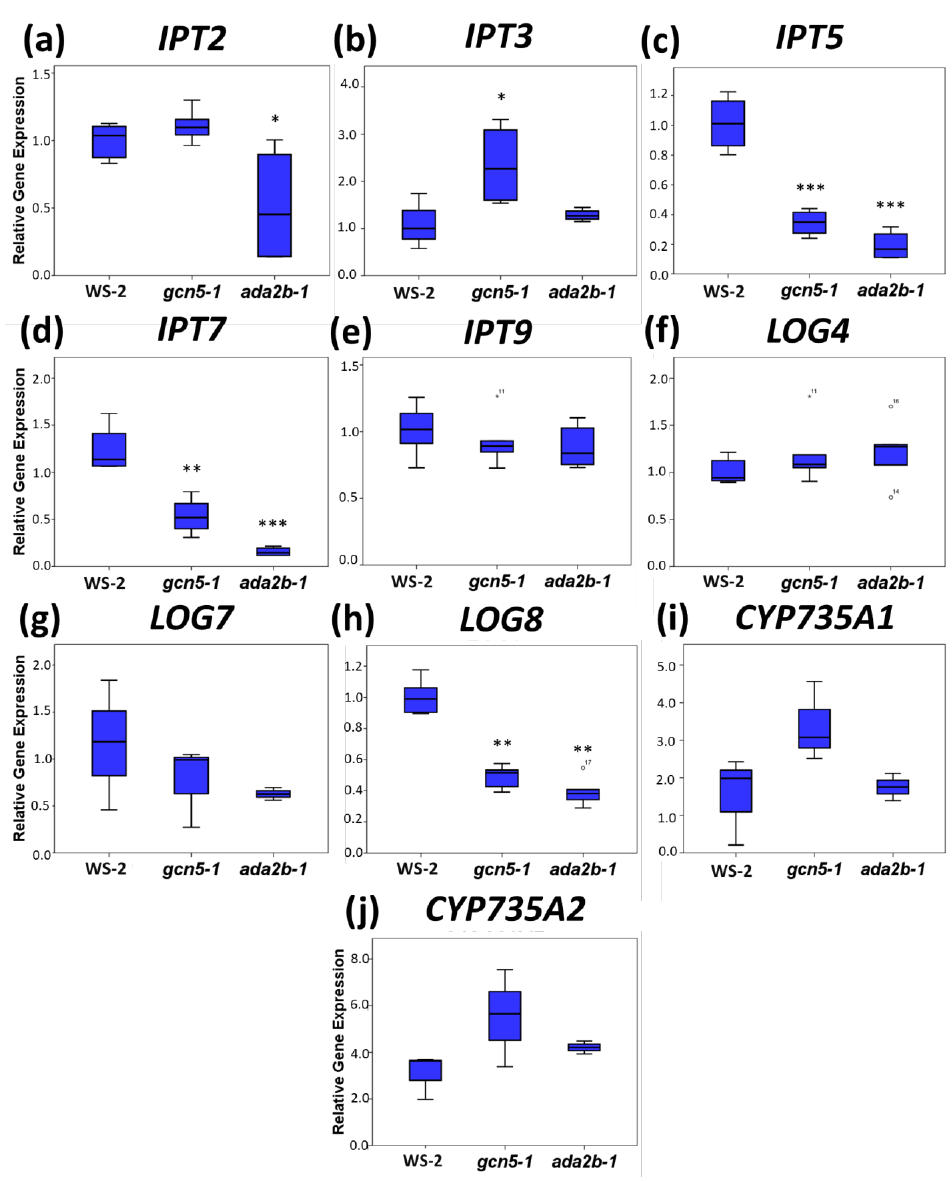
Figure 3. The role of GCN5 and ADA2bin cytokinin biosynthesis-related gene expression in Arabidopsis thaliana roots. The analysis was carried out in roots of seven-day-old Ws-2, gcn5-1 , and 1 plants using quantitative Reverse Transcription Polymerase Chain Reaction (qRT-PCR) for the genes ( a ) IPT2 , ( b ) IPT3 , ( c ) IPT5 , ( d ) IPT7 , ( e ) IPT9 , ( f ) LOG4 , ( g ) LOG7 , ( h ) LOG8, ( i ) CYP735A1 ,